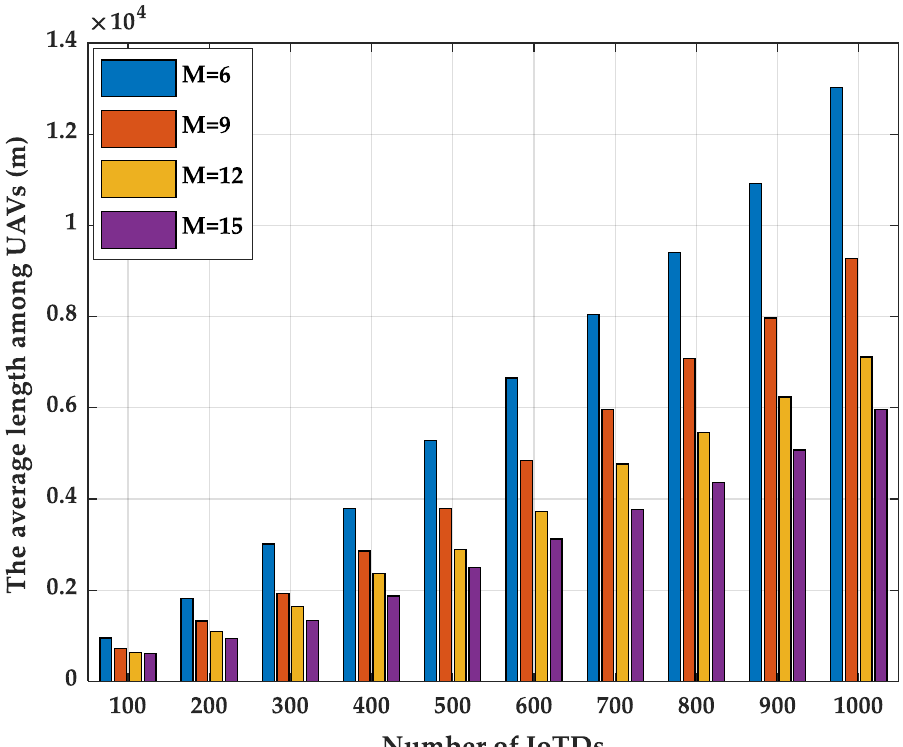
Figure 6. The average trajectory of 6, 9, 12, and 15 UAVs.